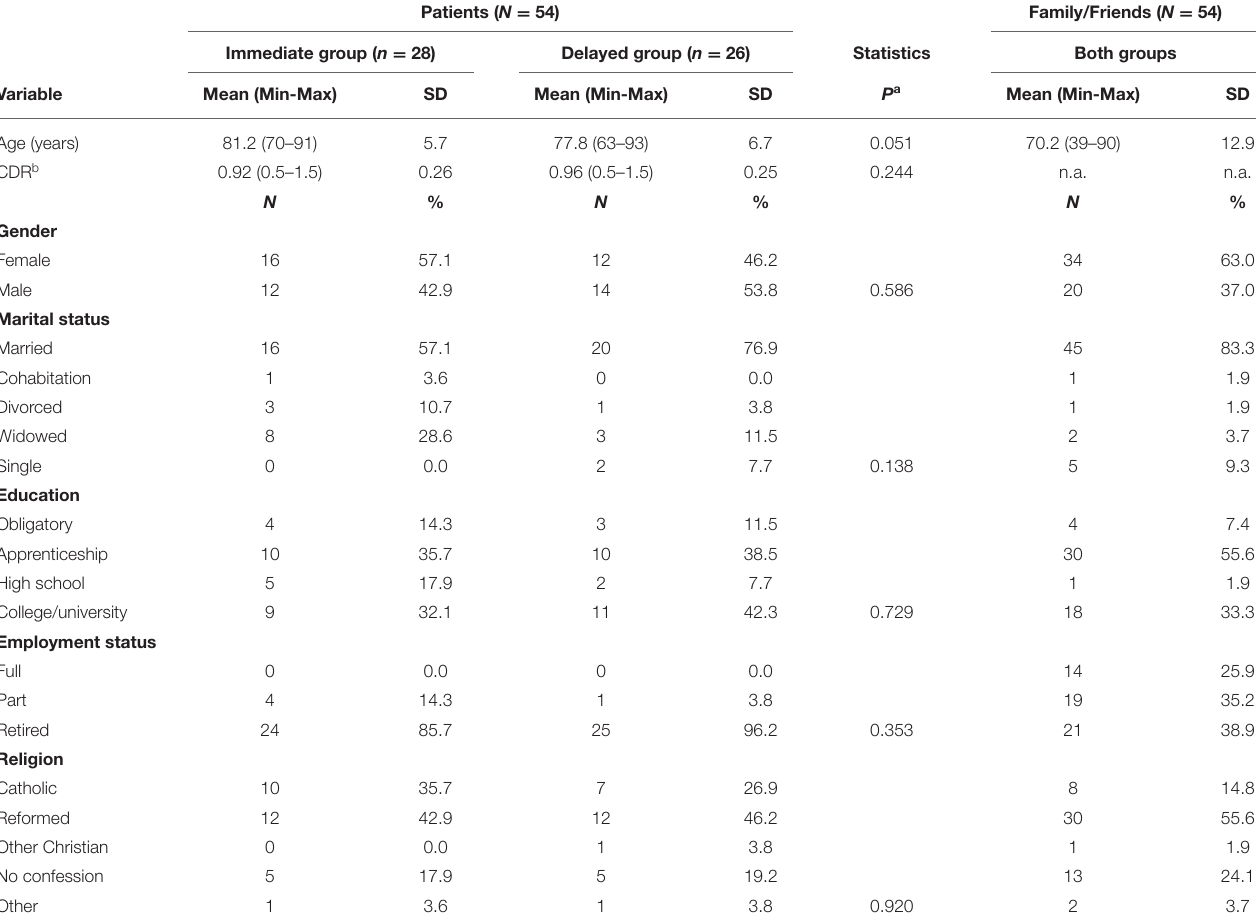
TABLE 1 | Demographic and clinical characteristics of subjects with early stage dementia ( N = 54) and family members/close friends ( N = 54). Patients ( N =